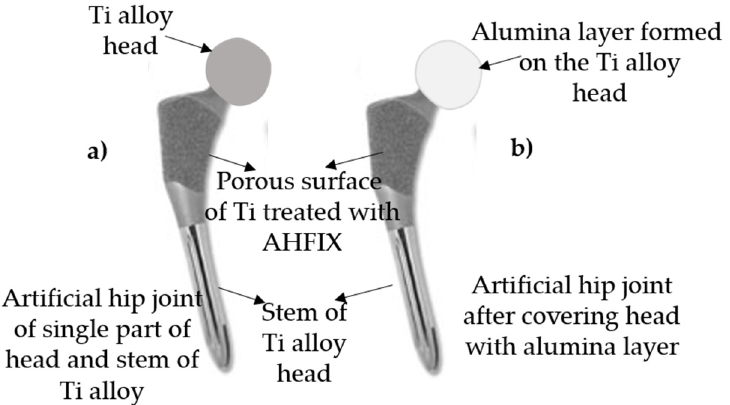
Figure 2. New design of artificial hip joint made of single part of head and stem of Ti alloy before ( a ) and after alumina layer formed on the head part ( b ).